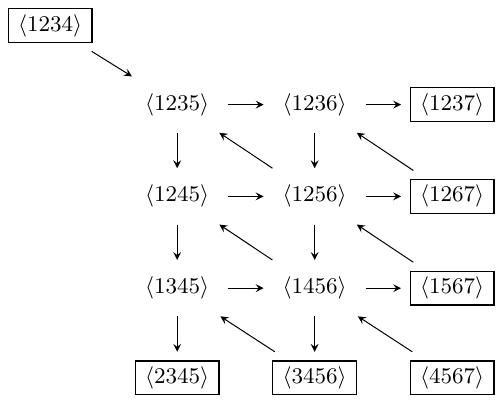
Figure 7. The initial cluster of the Conf 7 ( P 3 ) cluster algebra, relevant for heptagon amplitudes. Finally, admissible triples correspond to corners of (cid:12)gure 3, i.e. to clusters themselves. They are codimension-three or dimension-zero subalgebras and as an example we could take the triplet fh 1235 i ; h 1245 i ; h 1345 ig which de(cid:12)nes the initial